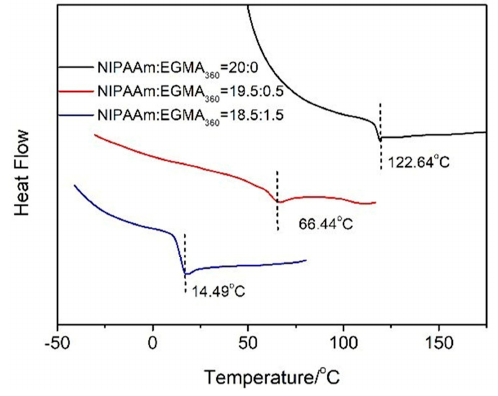
Figure 7. DSC curves of alginate-Ca 2+ /P(NIPAAm- co -EGMA 360 ) hydrogels. The monomer ratios of NIPAAm to EGMA are 20:0, 19.5:0.5, and 18.5:1.5. T g values are indicated by vertical dashed lines.